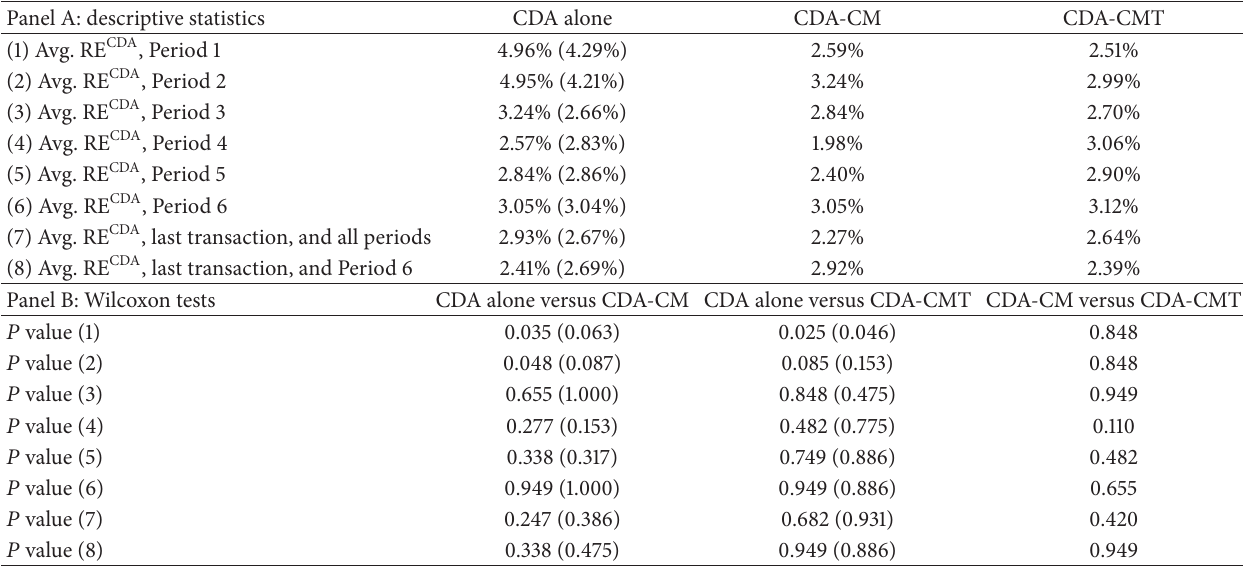
Table 5: Average RE CDA values and results of corresponding Wilcoxon rank sum tests. Results without the first CDA session in